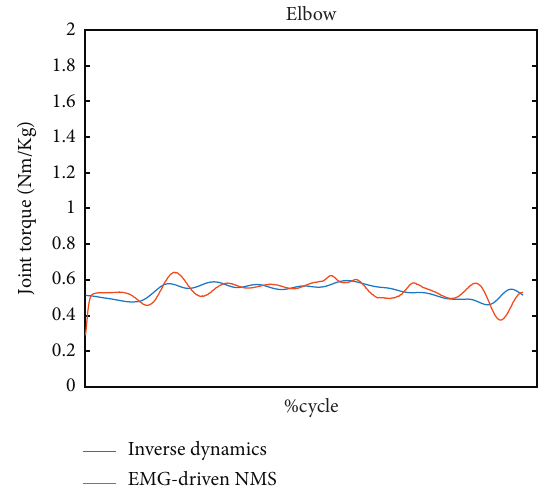
Figure 4: Elbow joint torque (normalized by body mass) estimated via inverse dynamics and EMG-driven NMS